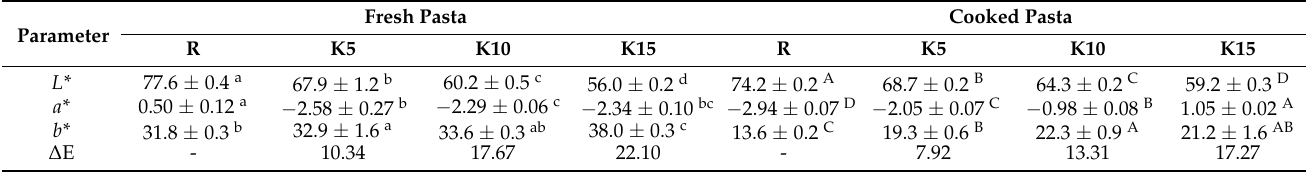
Table 3. Color parameters of pasta enriched with kiwifruit.